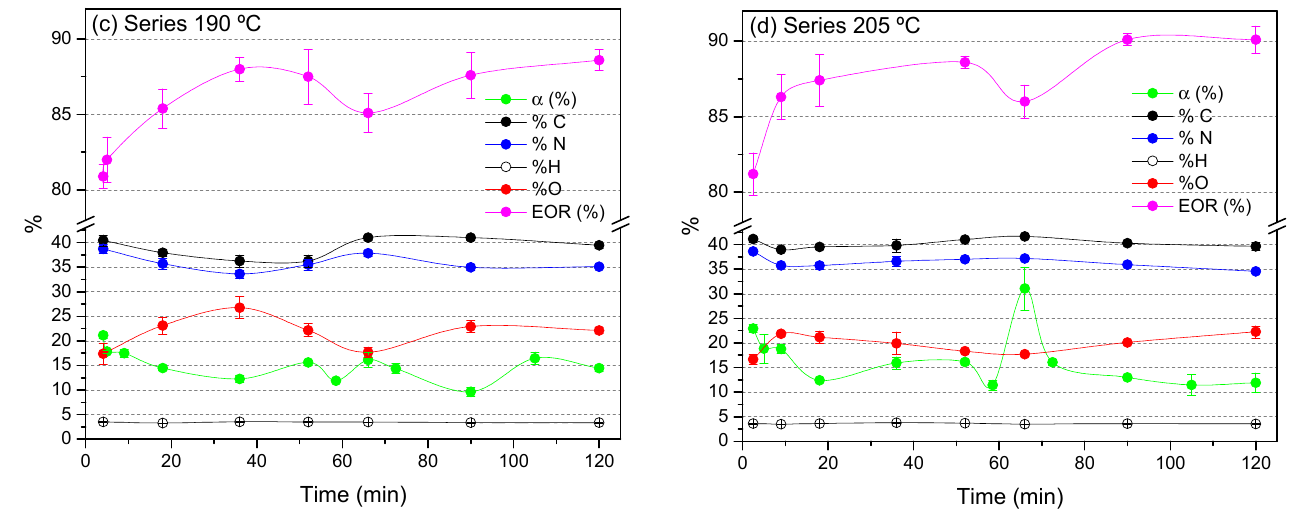
Figure 1. Evolution of NH 4 CN polymerization over the reaction time. ( a ) Series 80 °C is shown as repre-